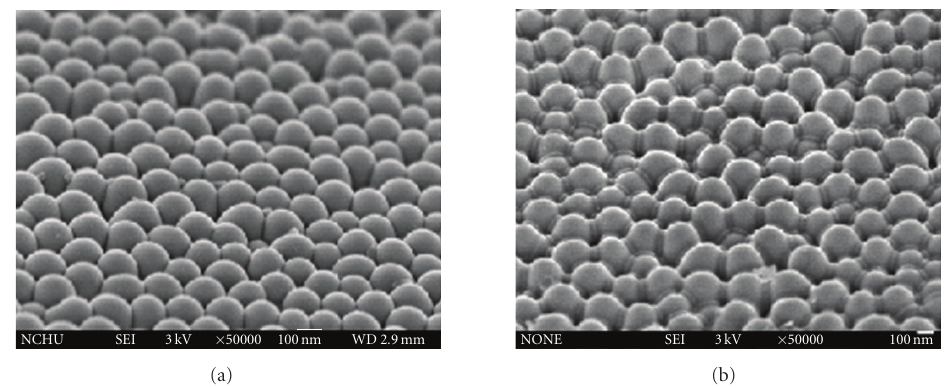
Figure 3: SEM images of the barrier-layer surfaces: (a) original, (b) after 35 minutes of etching.